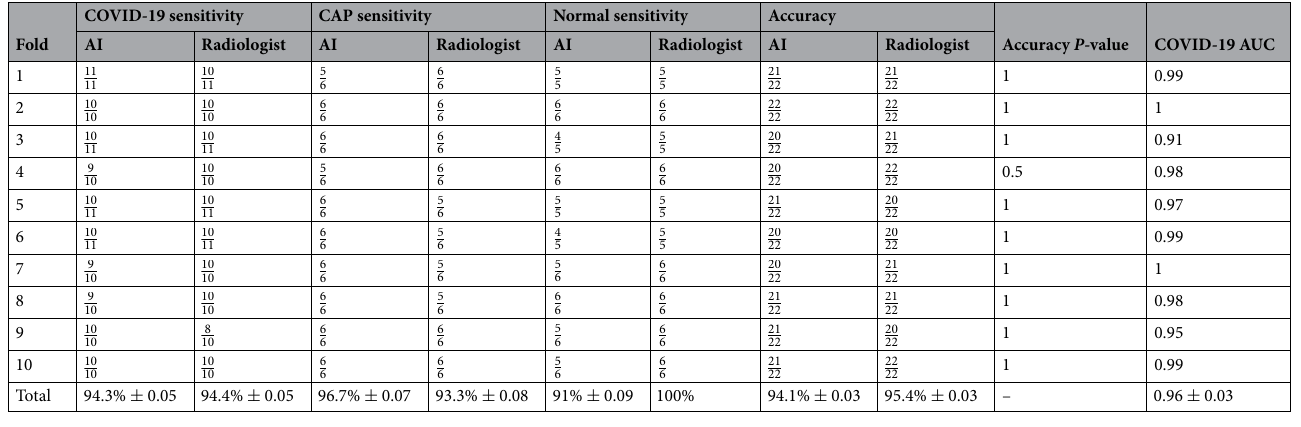
Table 3. Performance of the AI model and the radiologist blind to the labels, using both CT scans and clinical data.